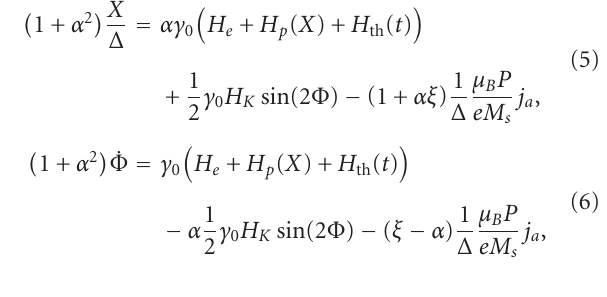
di ff erent points δ ( (cid:2) r −